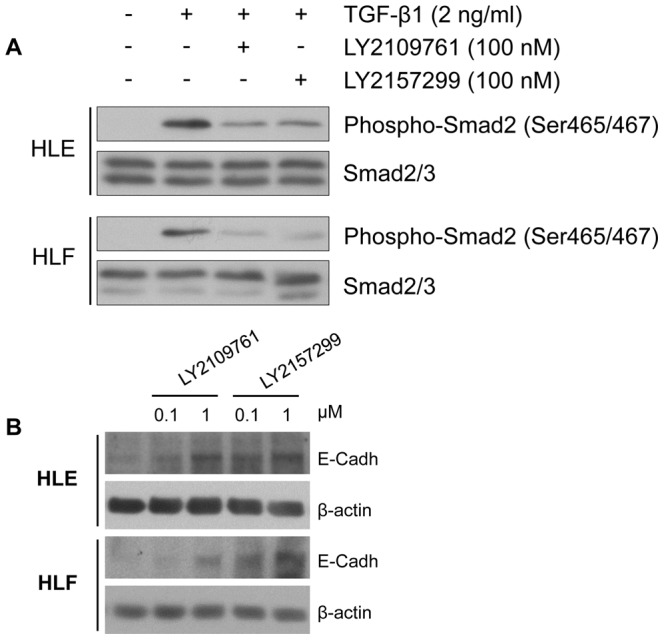
Effect of LY2109761 and LY2157299 on SMAD2 phosphorylation upon TGF-β1.(A) Two different HCC cell lines HLE and HLF were pretreated for 16 hours with 100 nM of LY2109761 or LY2157299 and then stimulated with 2 ng of TGF-β1 for 30 min. Phosphorylation of SMAD2 was detected in immunoblots using a rabbit polyclonal antibody directed against Phospho-Smad2 (Ser465/467). (B) Effect of LY2109761 and LY2157299 on E-cadherin expression in HLE and HLF. Increasing expression of E-cadherin is observed in HLE and HLF cells after treatment with both inhibitors for 48 hours.